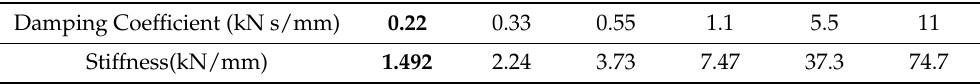
Table 2. Those essential parameters of the damping and stiffness utilized in the finite element modeling. Damping Coefficient (kN